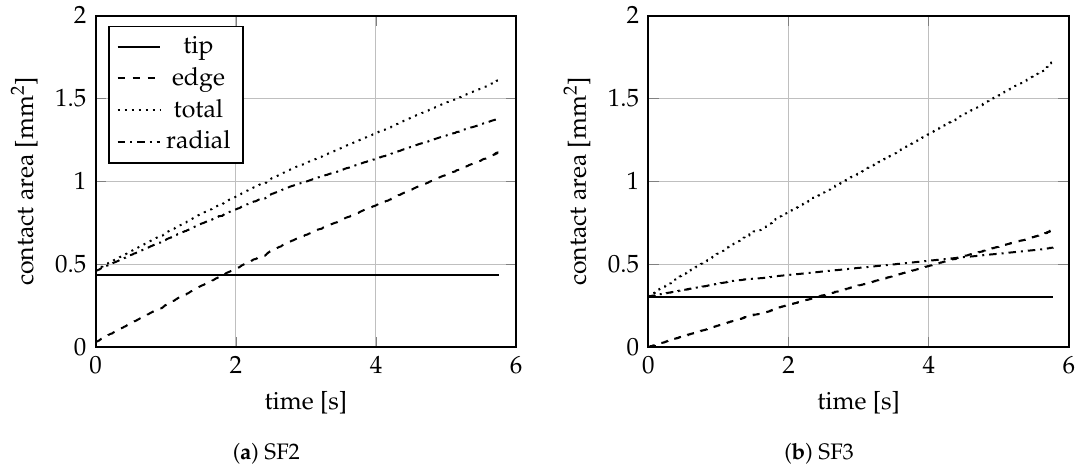
Figure 10. Theoretical development of the size of the contact surface on each edge over time and hence incursion